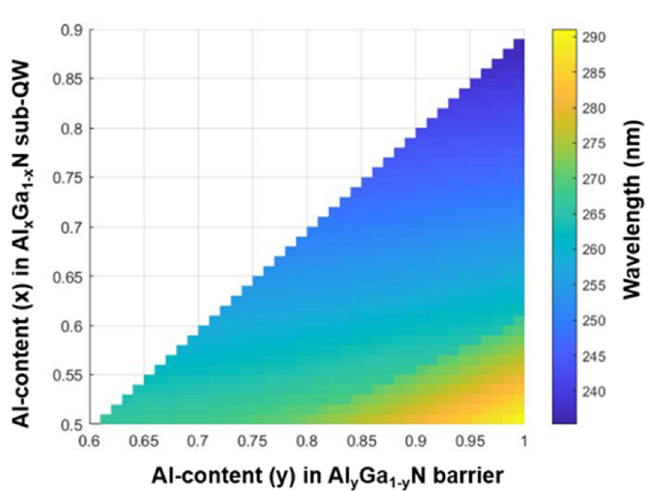
Figure 3. Wavelength color map for a 3 Å AlGaN-delta-GaN QW with different sub-QWs and barrier Al contents.